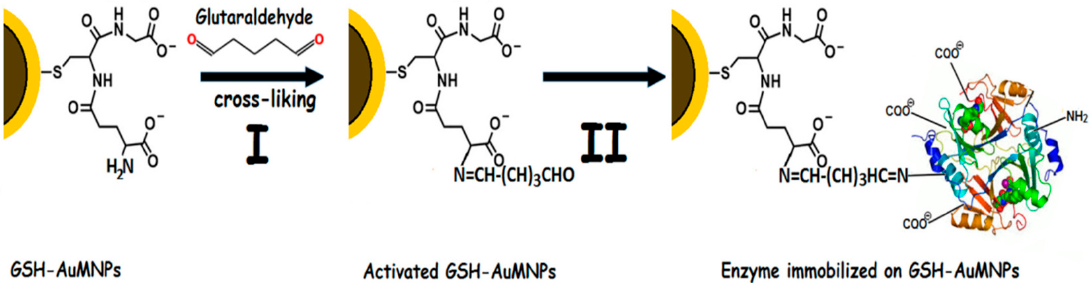
Figure 4. Enzyme immobilization steps including ( I ) cross-linkage of glutathione decorated Fe 3 O 4 -Au magnetic nanoparticles (GSH-AuMNPs) with GA, and ( II ) enzyme immobilization on GSH-AuMNPs surface. Reprinted from Mohammadi et al. [23], with permission from Elsevier. Copyright (2018) Elsevier B.V.